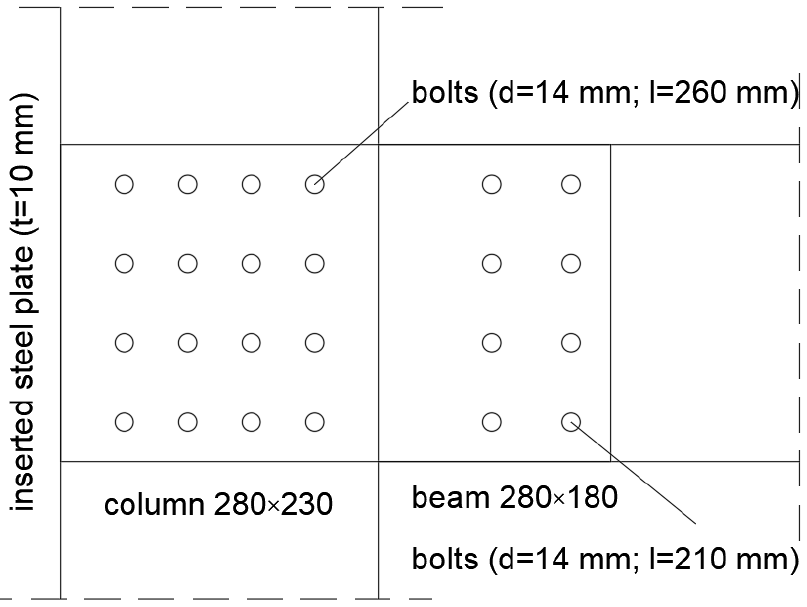
Figure 5. Bolted slotted-in steel plate connection applied in frame tested by